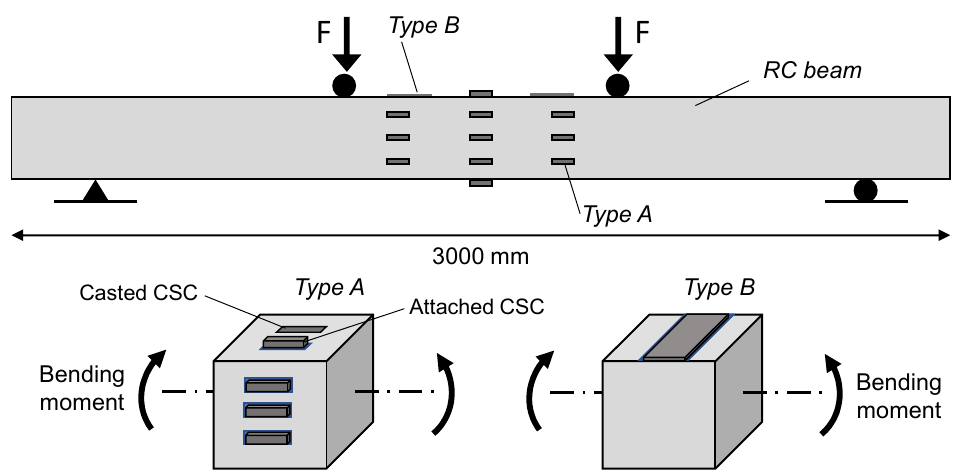
Figure 6. Distribution of CSC sensors and patches on RC beam under four-point bending test (adapted from [77]).